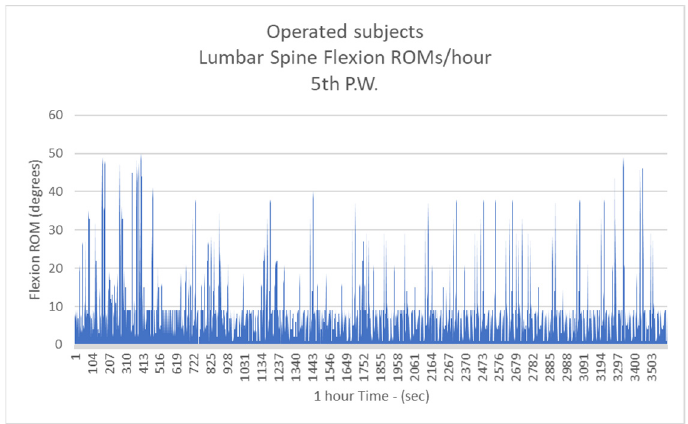
Figure 9. The number of more than 10 degrees of Lumbar Spine Flexions (LSFs) per hour for operated subjects at the 5th postoperative week.